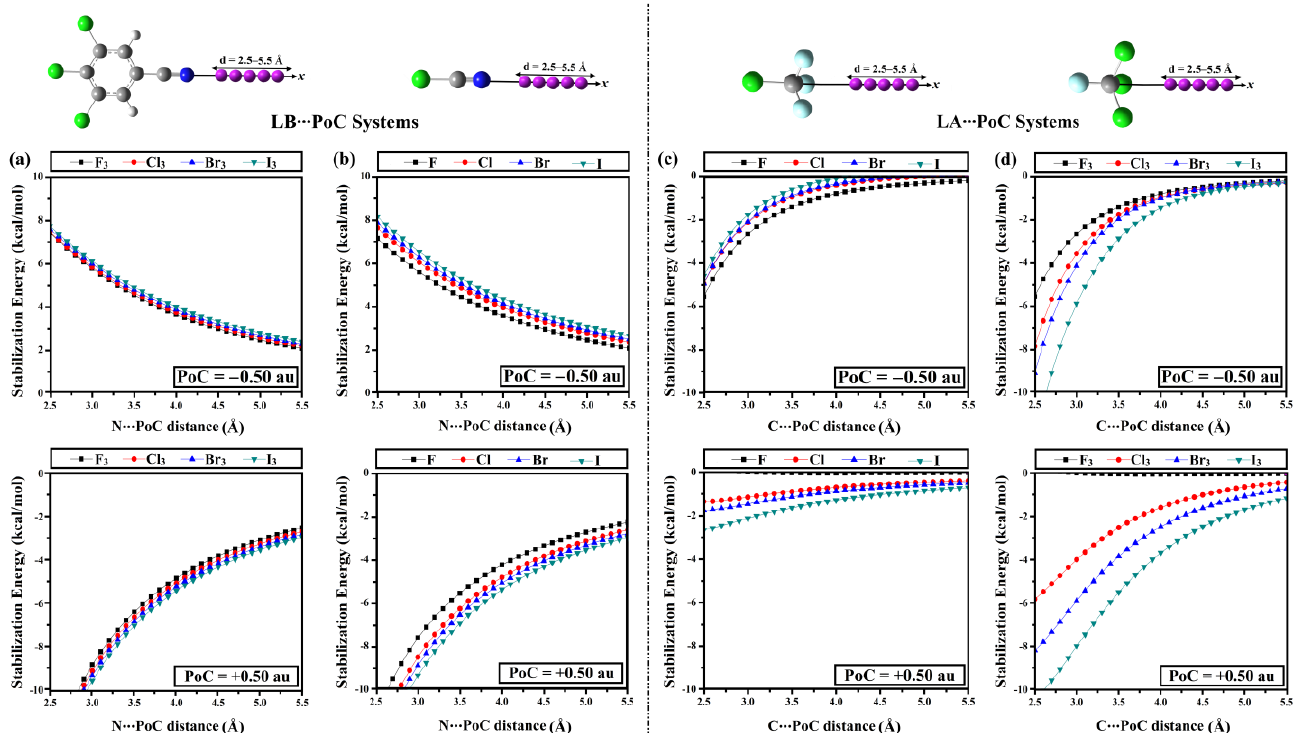
Figure 3. Stabilization/destabilization energy curve of the ( a ) NC-C 6 H 2 -X 3 ∙∙∙, ( b ) NCX∙∙∙, ( c ) W-C-F 3 ∙∙∙, and ( d ) F-C-X 3 ∙∙∙PoC systems (where X and W = F, Cl, Br, and I) under the effect of PoC = ±0.50 au at N/C∙∙∙PoC distance ranging from 2.5 to 5.5 Å.